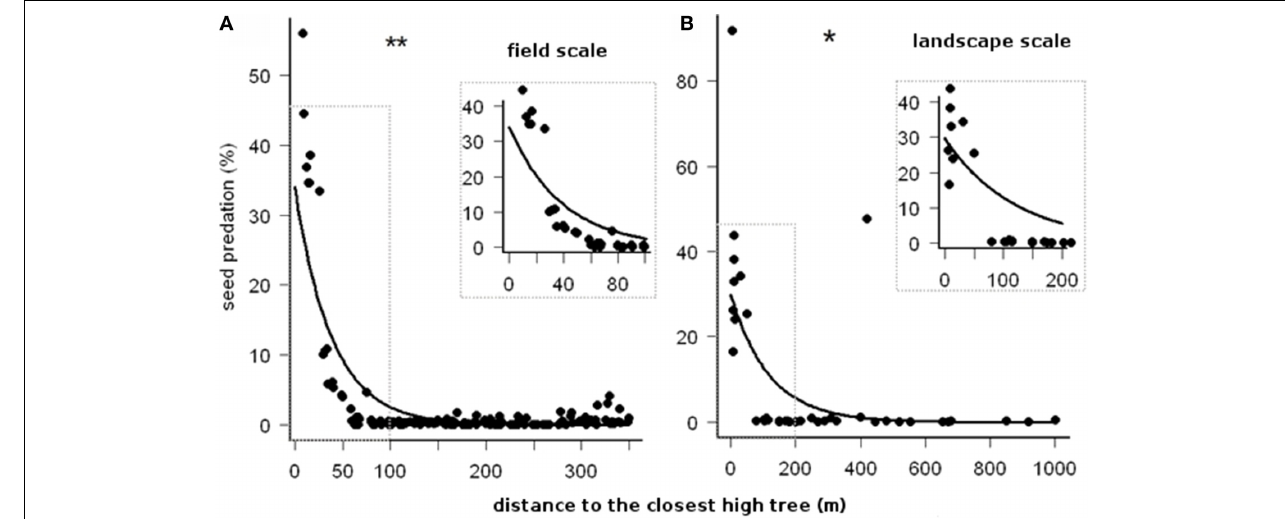
FIGURE 4 | Percentage of seed predation per field and intercept/ sampling point (shown as mean seed predation per sampling point) in relation to the distance of closest high tree, (A) of the entire field sampled in 2010 and in the inset, intercept points that were not further